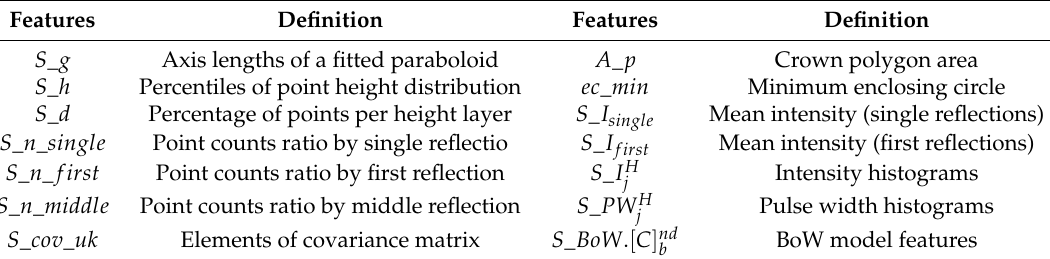
Table 2. Description of the generated features for each tree